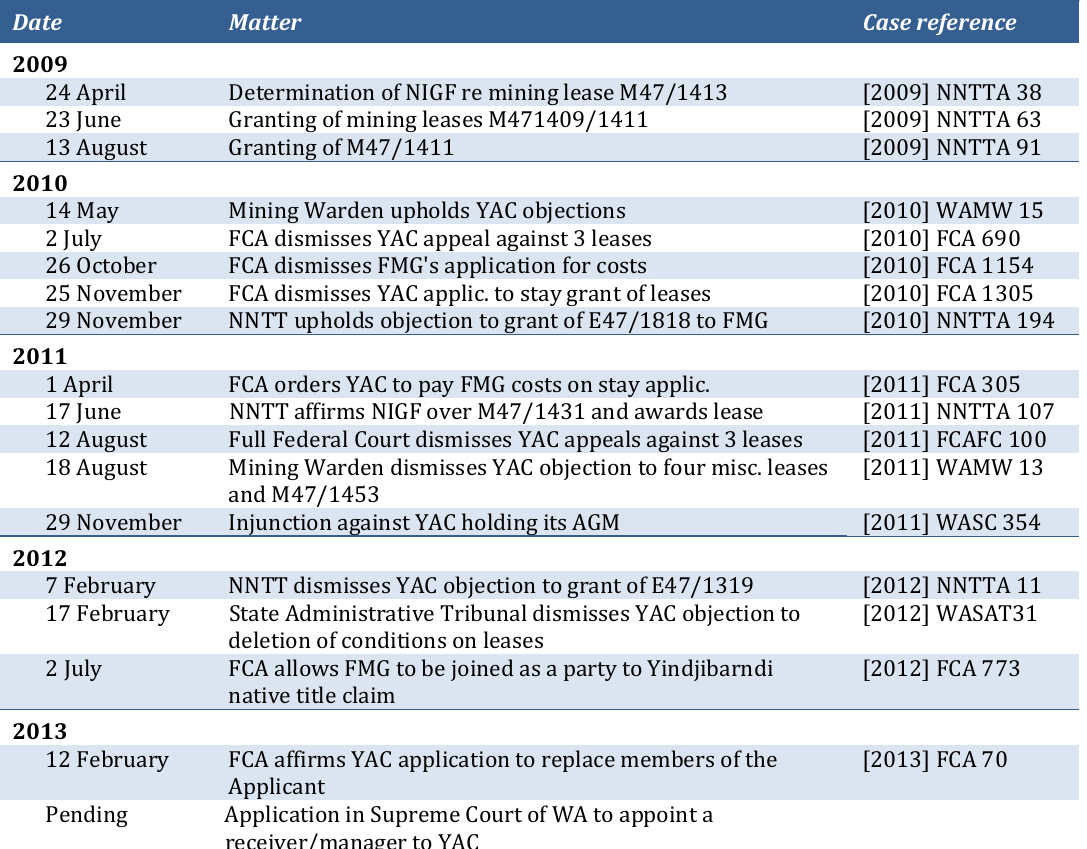
Table 1: Legal and administrative proceedings between YAC and FMG/WMYAC for the Solomon Hub